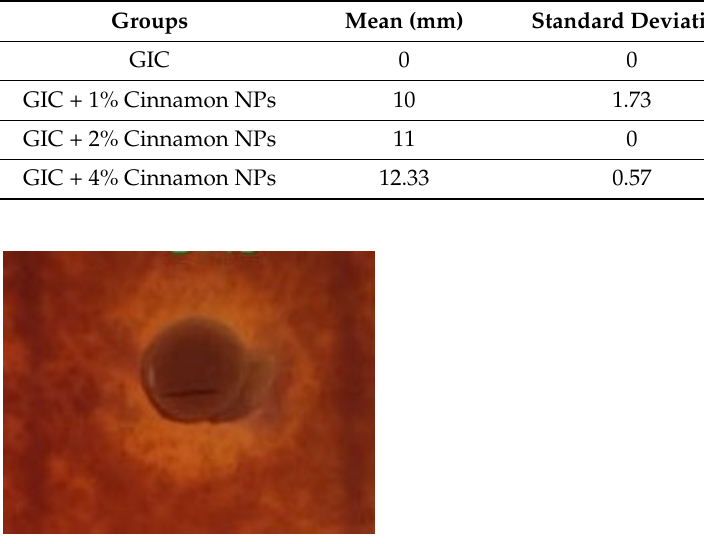
Figure 2. Inhibition zone of S. mutans bacteria for GIC containing cinnamon NPs.